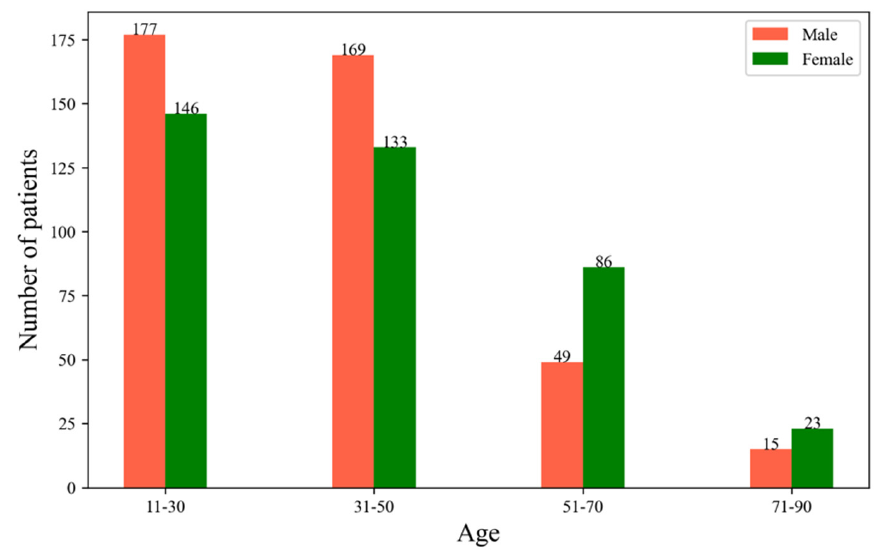
Figure 3. Number of patients in different age and gender groups.